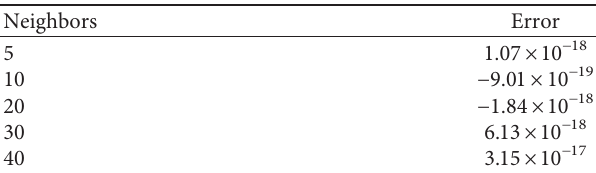
Table 5: Errors after dimension reduction of LLE.